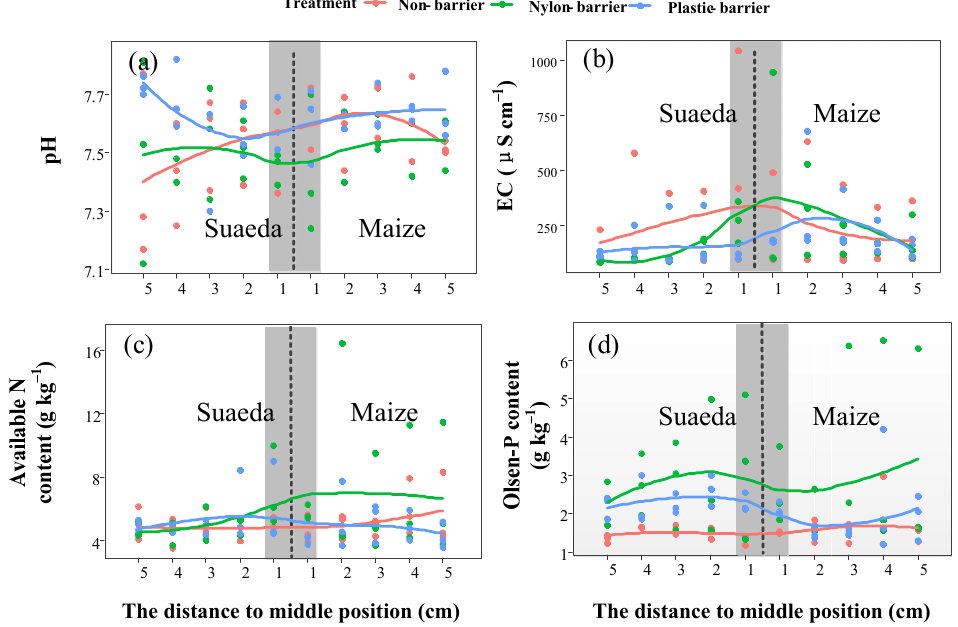
Figure 6. Variations in soil properties in the different treatments: ( a ) pH; ( b ) EC; and ( c ) available N content; ( d ) Olsen-P content of the soil from the middle positions. Dotted black lines and gray shadowing represent the middle positions and the interfaces of the two species, respectively, in the different treatments.